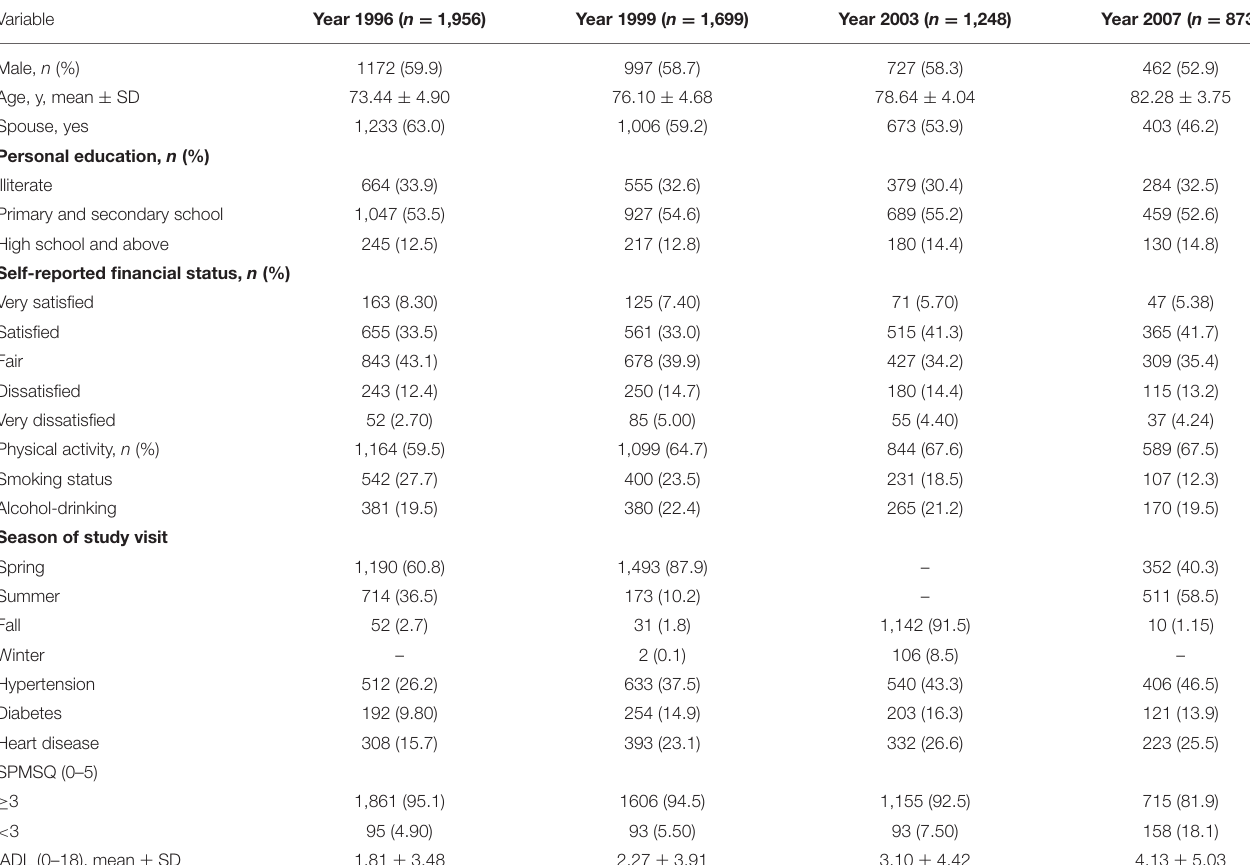
TABLE 1 | TLSA participant data for each study